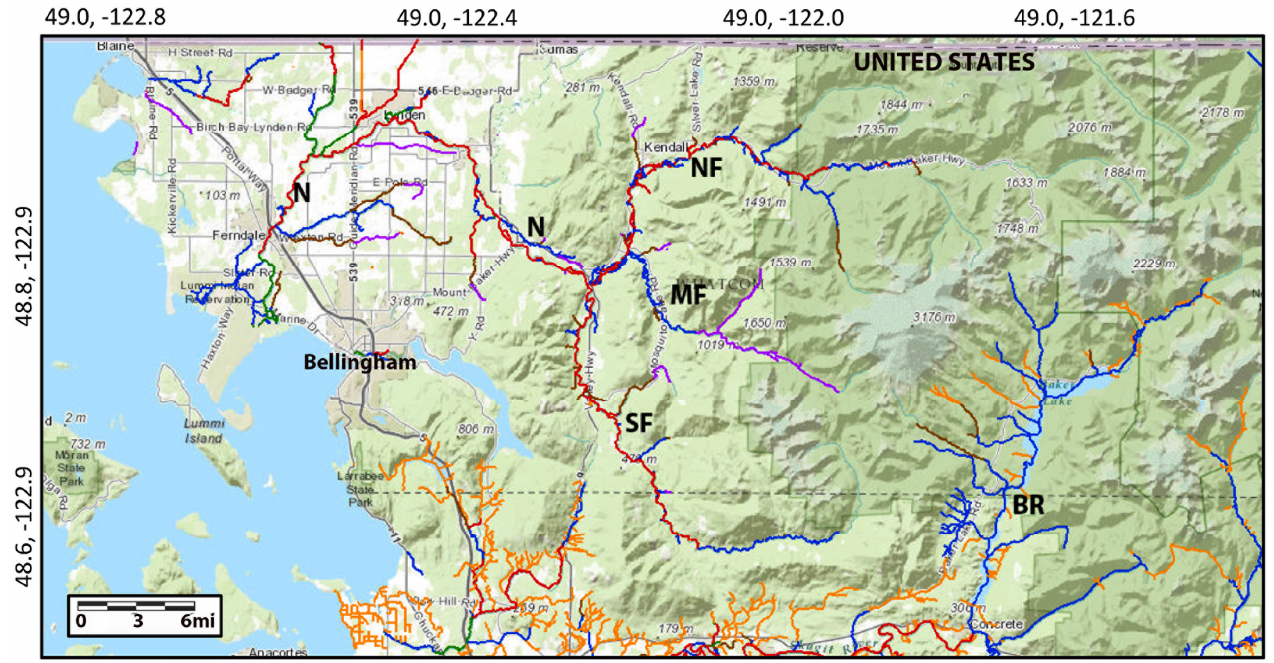
Figure 6. From the WDFW SalmonScape, this map indicates the extent of Chinook salmon in the Nooksack (N) and Baker River (BR) watersheds. Including the Nooksack sub-basins; MF = Middle Fork, NF = North Fork, SF = South Fork. Red = documented spawning, Blue = Documented presence, Green = Documented rearing, Yellow = Modelled presence, Purple = Blocked.